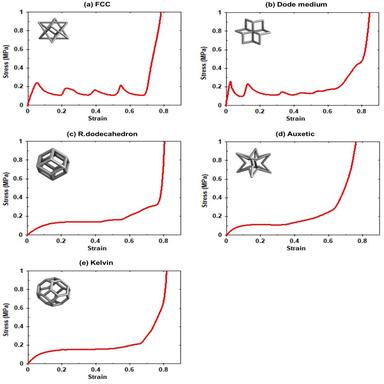
Stress-strain relationships of set 1 structures: a) FCC, b) dode medium, c) rhombic-dodecahedron, d) auxetic, and e) kelvin.